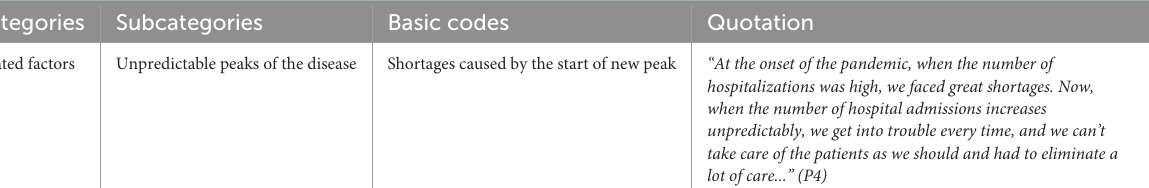
TABLE 4 An example of data analysis.